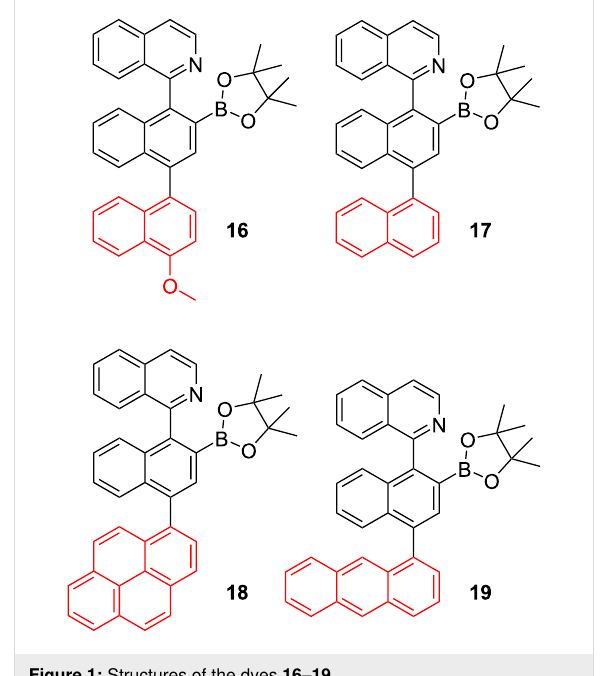
Figure 1: Structures of the dyes 16 – 19